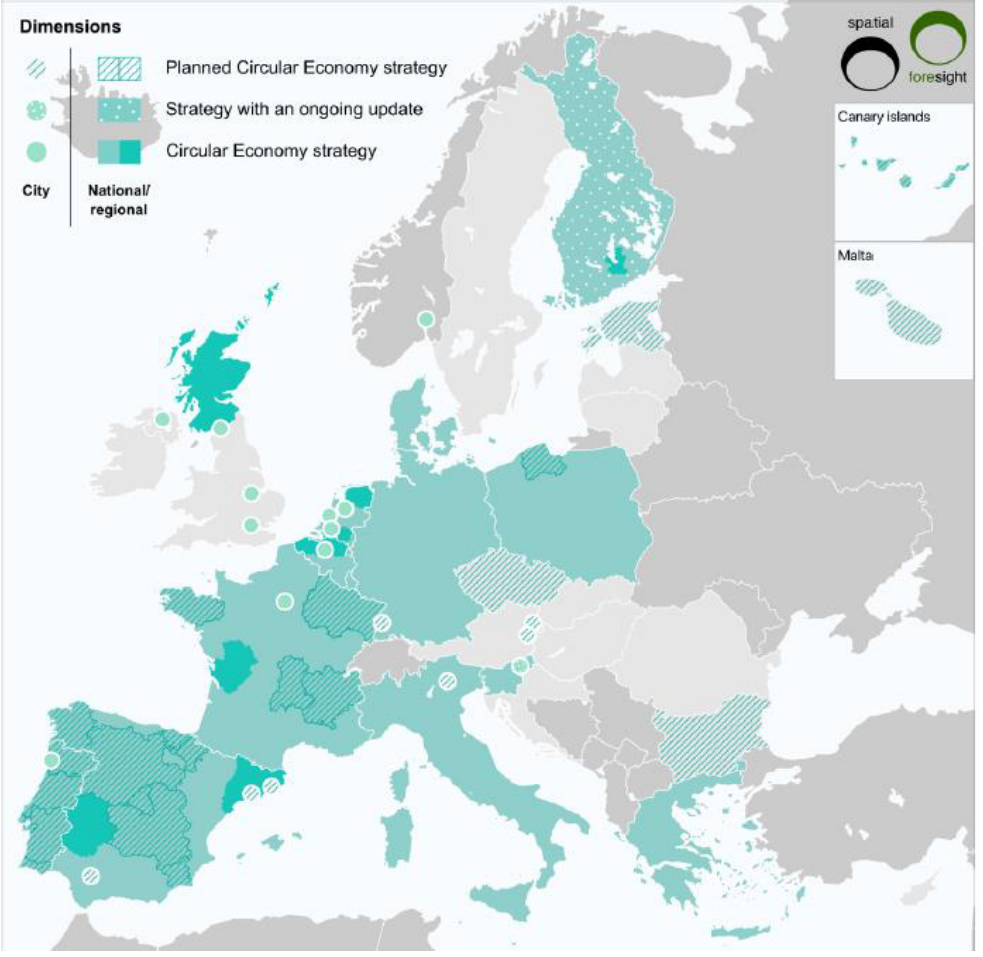
Figure 1. Overview of circular economy strategies (planned, updated and on-going) in Europe (Salvatori et al., 2019) [19].